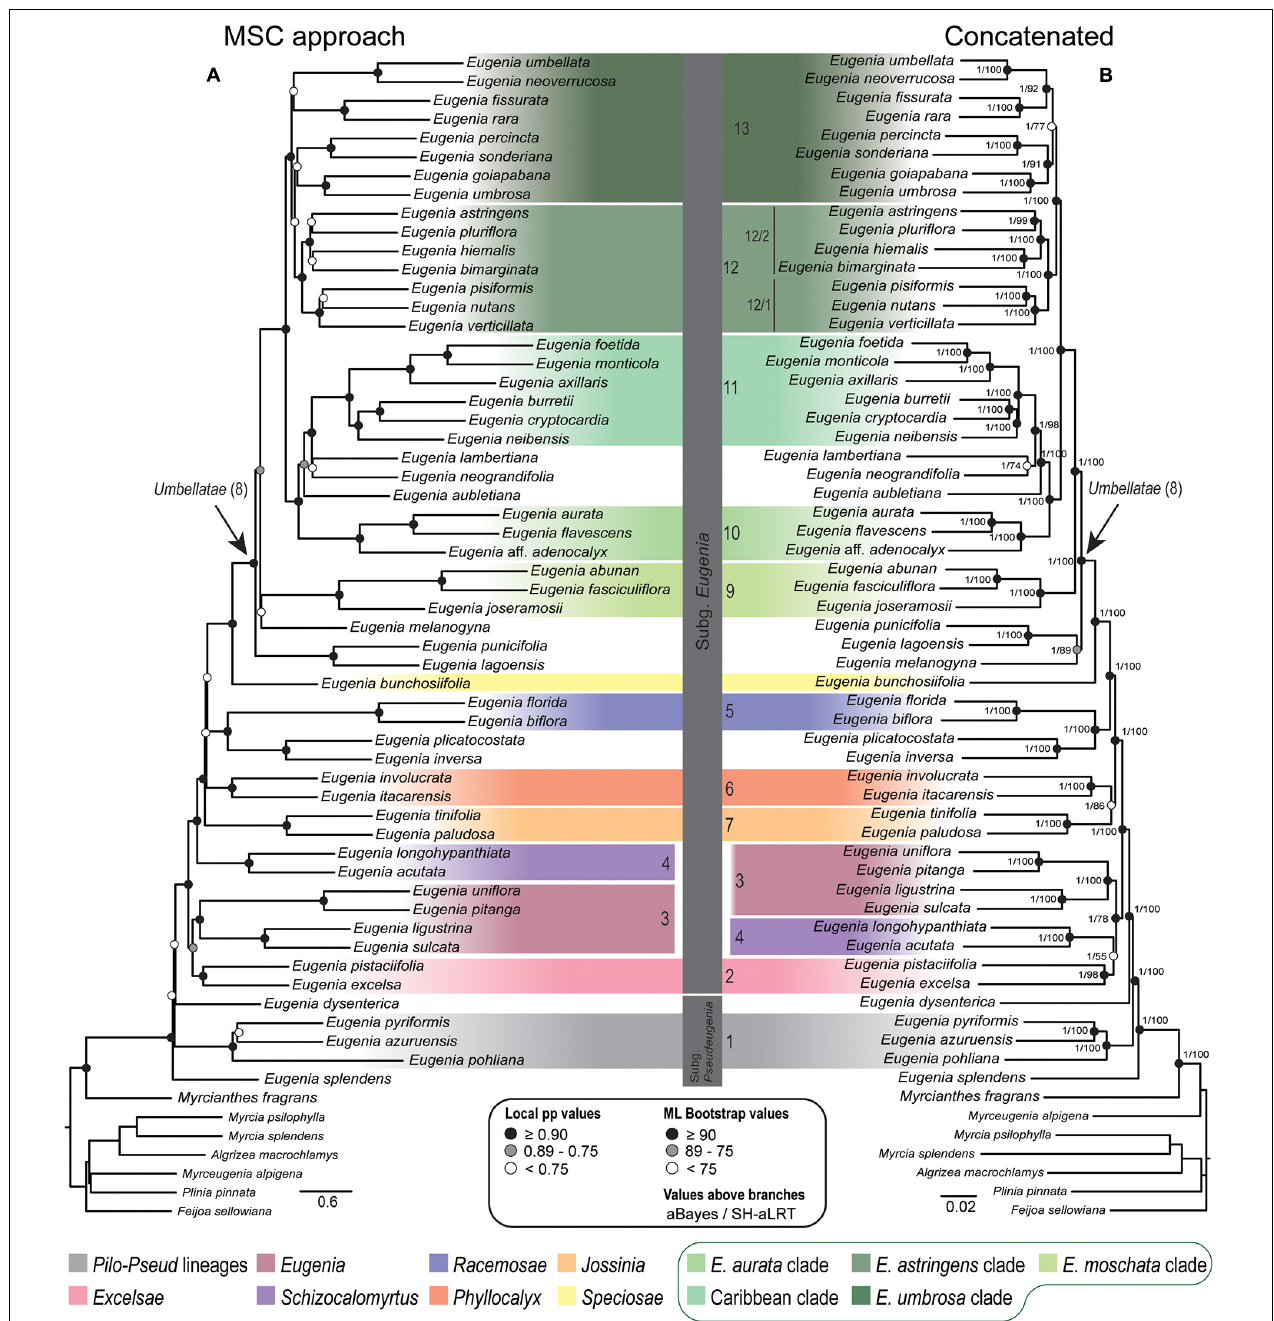
FIGURE 4 | Phylogenetic reconstructions of Eugenia based on the 306 nuclear coding loci with 239 additional intron regions targeted with the Angiosperm-353 probes combined in a genomic dataset (ncGD). (A) MSC tree using Astral with support values shown at the nodes as local pp. (B) Concatenated partitioned tree with ML support shown at the nodes as circles (see legend) and additional tests of branch support with values above branches (aBayes/SH-aLRT). Colored legend corresponds to the colored boxes (clades of Eugenia sect. Umbellatae are circled).